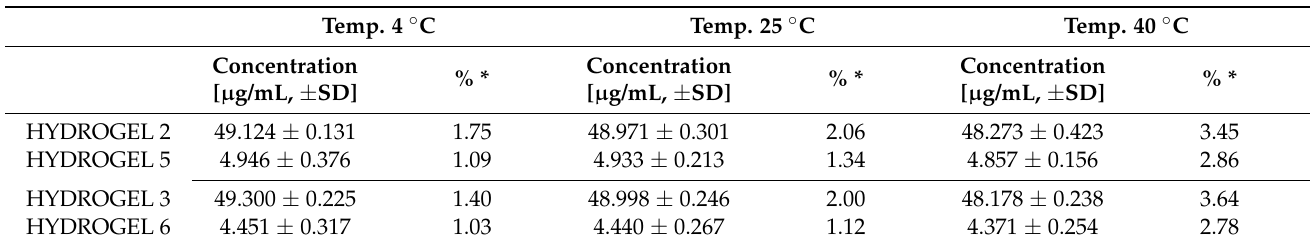
Table 5. Quantitative analysis of iridoid glycosides in the hydrogel formulations (2, 3, 5, and 6) after storage period of 60 days under various temperature conditions (4, 25, 40 ◦